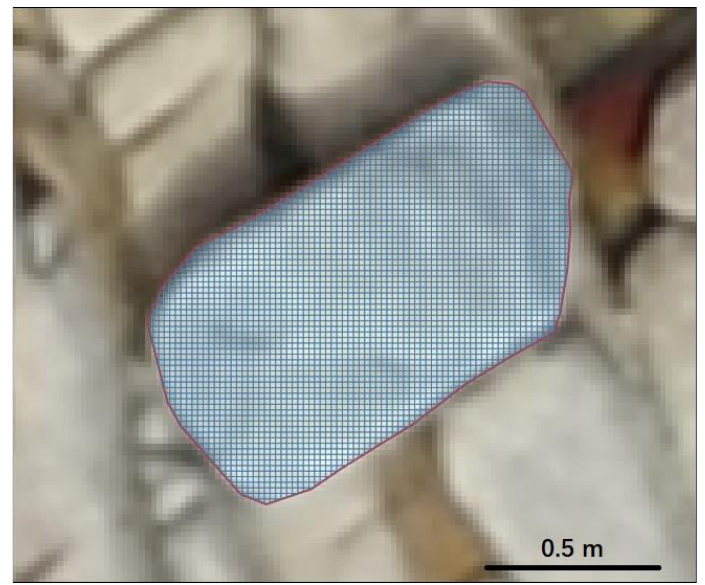
Figure 3. Illustration of the boulder gridding procedure.